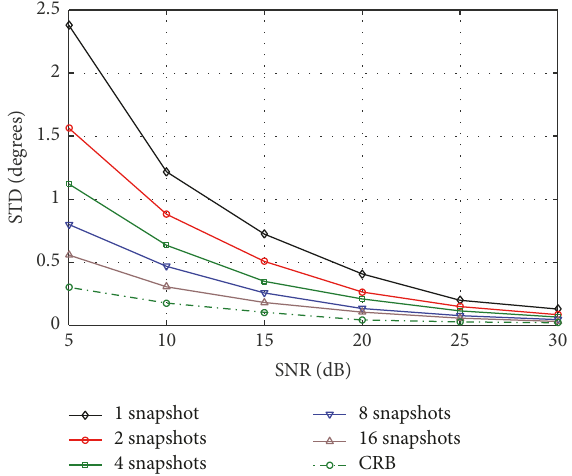
Figure 8: Scatter plot for three noncoherent sources located at (𝜃 1 = 55 ∘ ,𝜙 = 40 ∘ ) , (𝜃 = 60 ∘ , 𝜙 = 55 ∘ ) , and (𝜃 = 70 ∘ , 𝜙 = 65 ∘ ) with 1 2 2 3 3 SNR = 15dB.